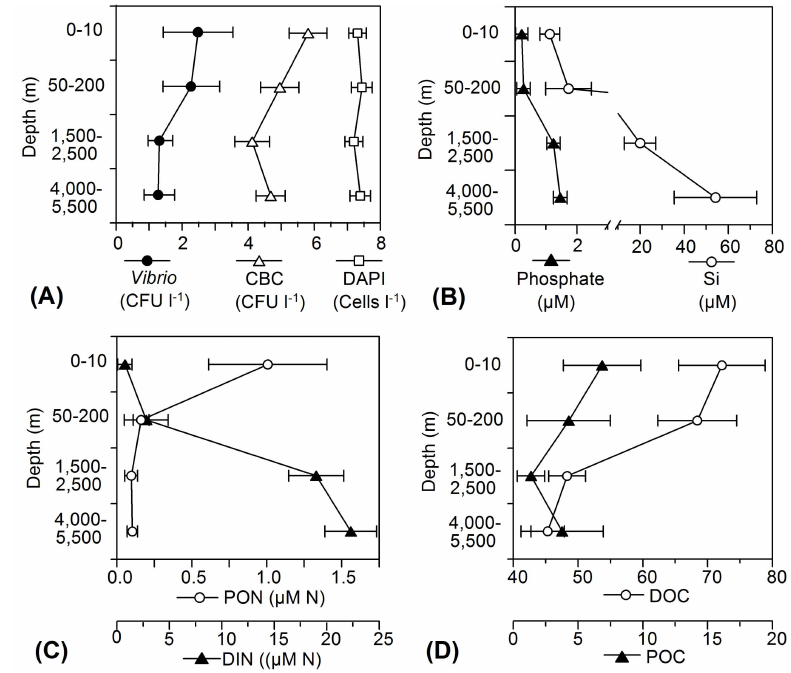
Fig. 6. Depth-wise changes in bacterial abundance and biogeochemical parameters. Samples were collected at 7 locations in the eastern Atlantic Ocean. Symbols and horizontal bars indicate average and standard deviation, respectively. For abbreviations refer to Fig. 2 and